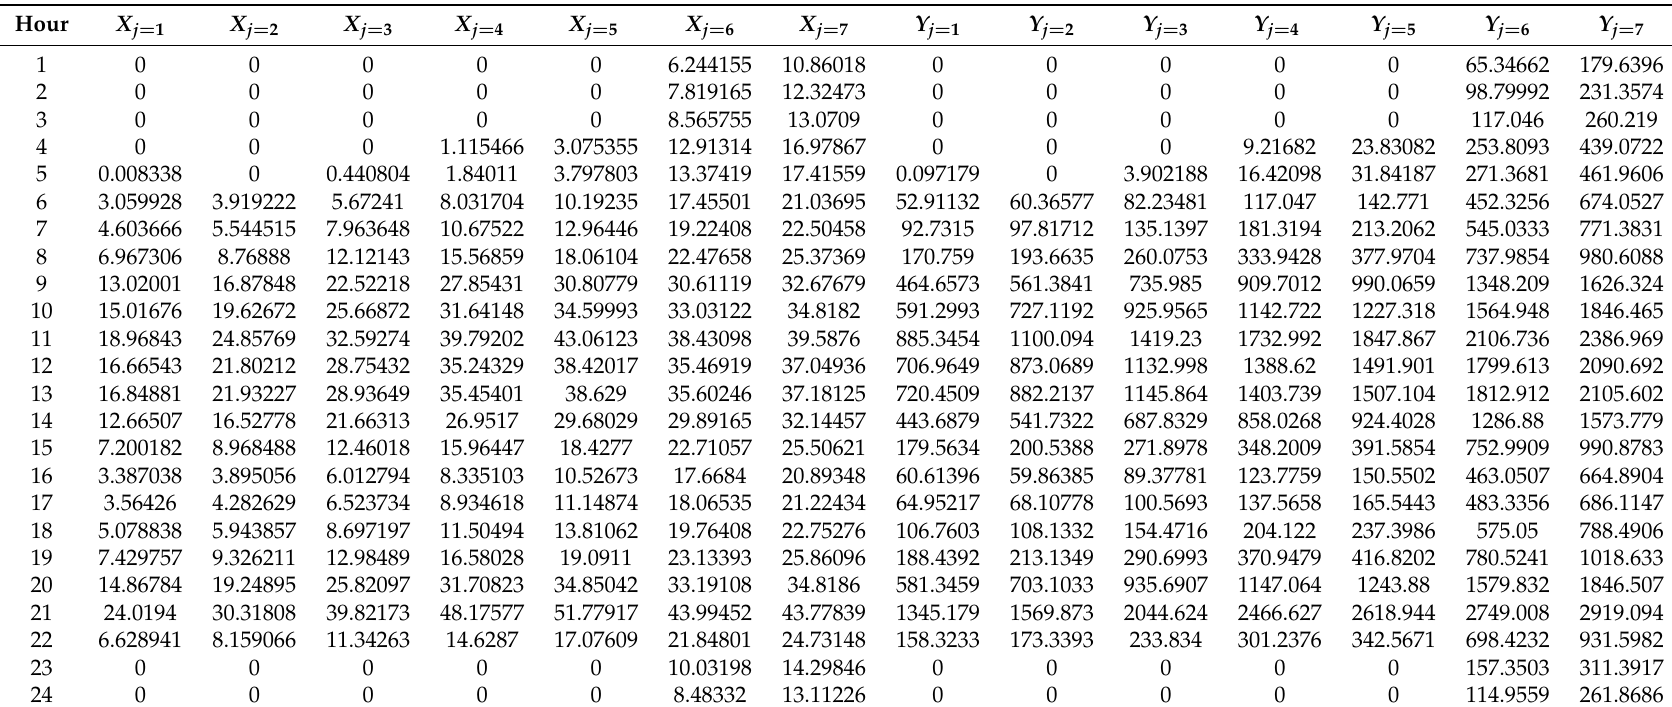
Table A2. Detailed demand response results for Case